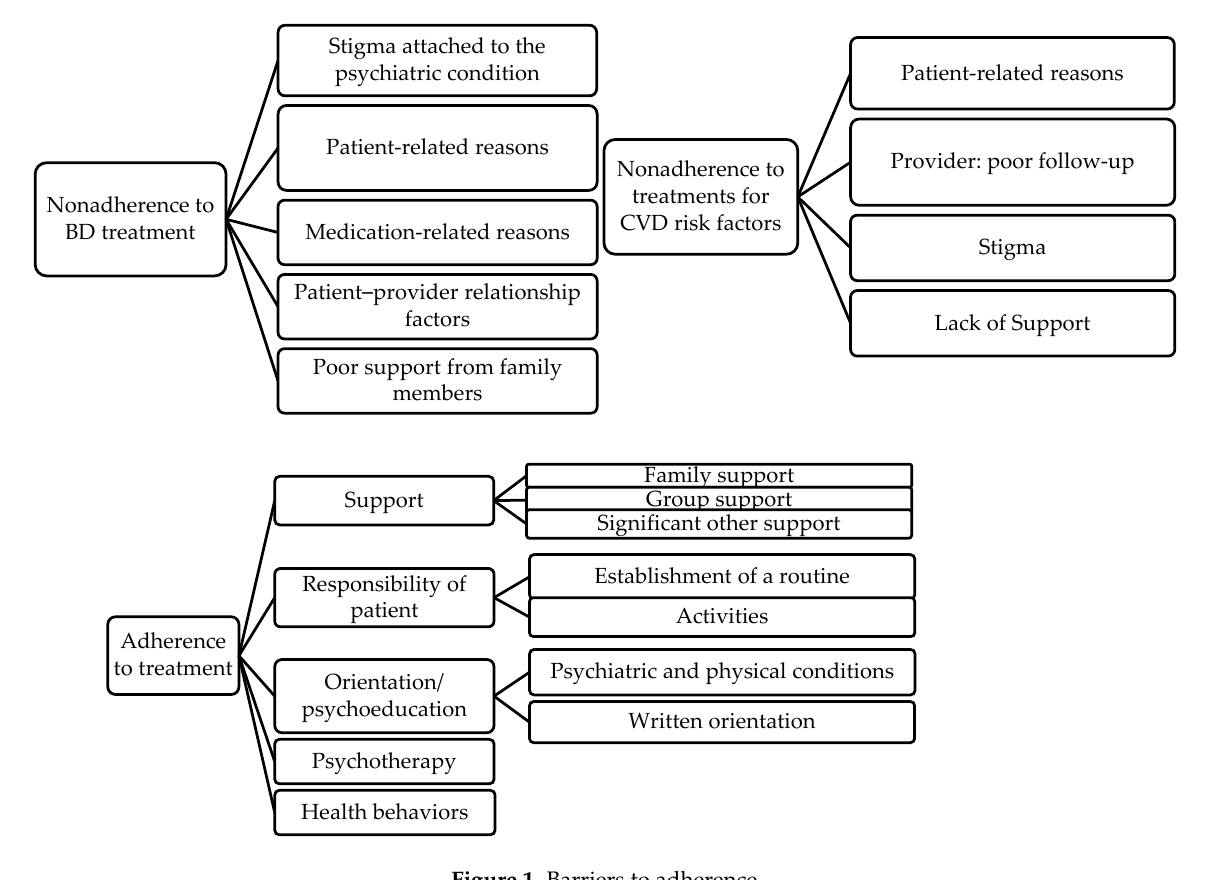
Figure 1. Barriers to adherence.